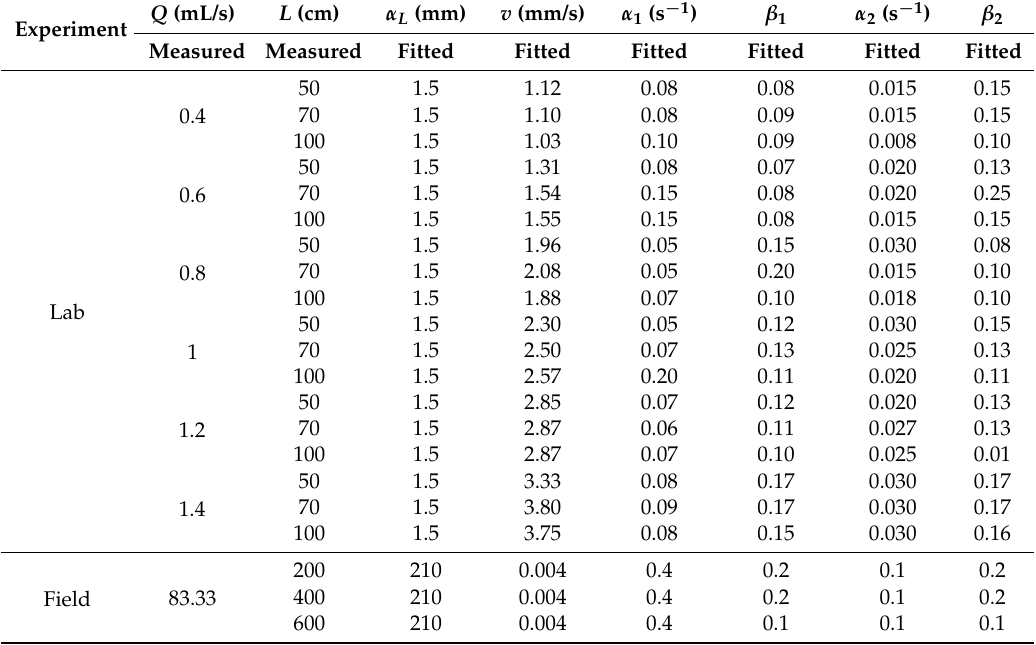
Table 4. The fitted parameters for the two-set MRMT model at different flow rates and travel distances. In the legend, α 1 and β 1 represent the mass transfer rate and capacity coefficient of the first immobile domain, respectively; and α 2 and β 2 are the mass transfer rate and capacity coefficient of the second immobile domain,